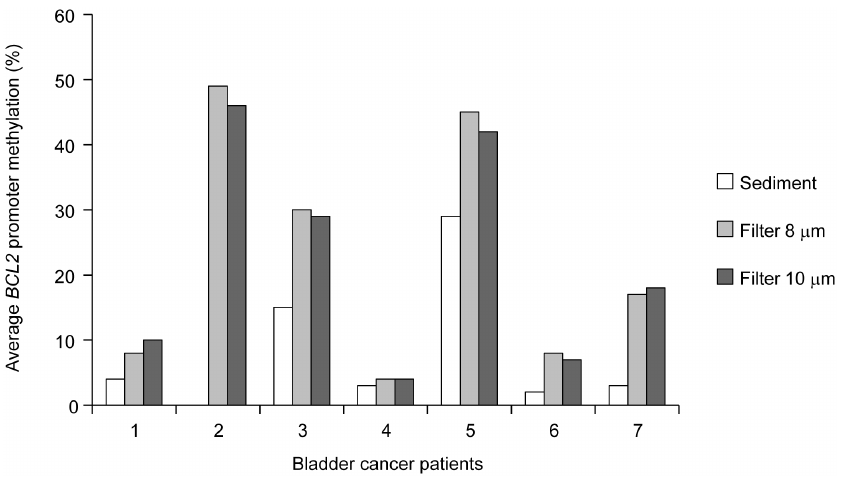
Figure 2. Comparison of levels of tumor-derived DNA in urine samples prepared by sedimentation or filtration. Average methylation levels of the BCL2 promoter CpG island in urine samples from seven bladder cancer patients, as determined by pyrosequencing. Sediment and two filter samples (8 and 10 m m pore size, respectively) were prepared from each urine sample. The sediment sample from patient 2 is missing due to failed DNA extraction.